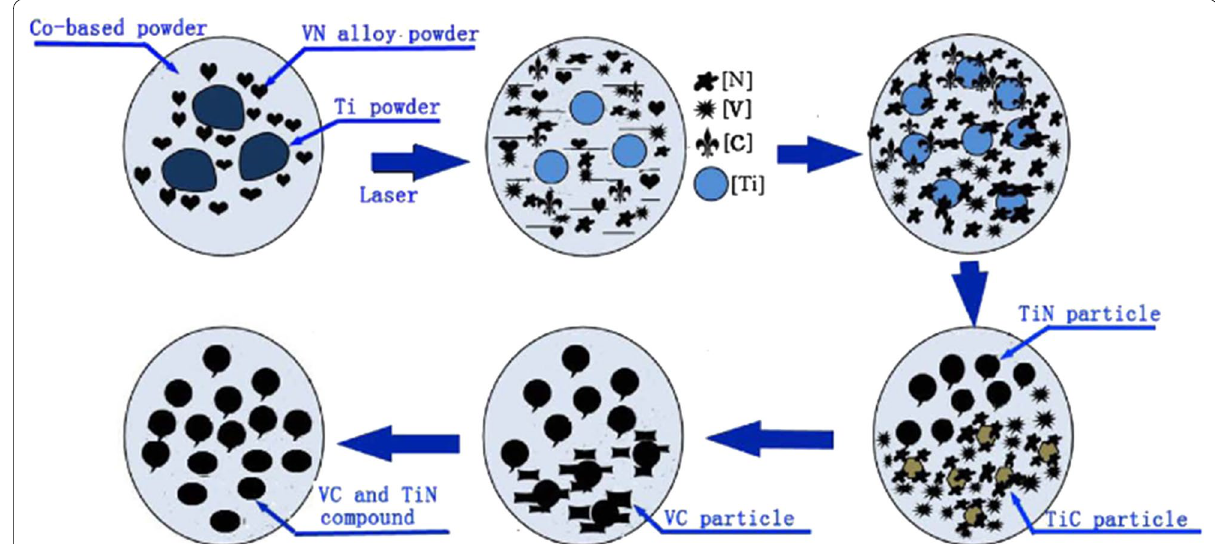
Figure 17 Diagram illustration for the action mechanism of Ti on the microstructure of VN alloy/Co-based composite coatings